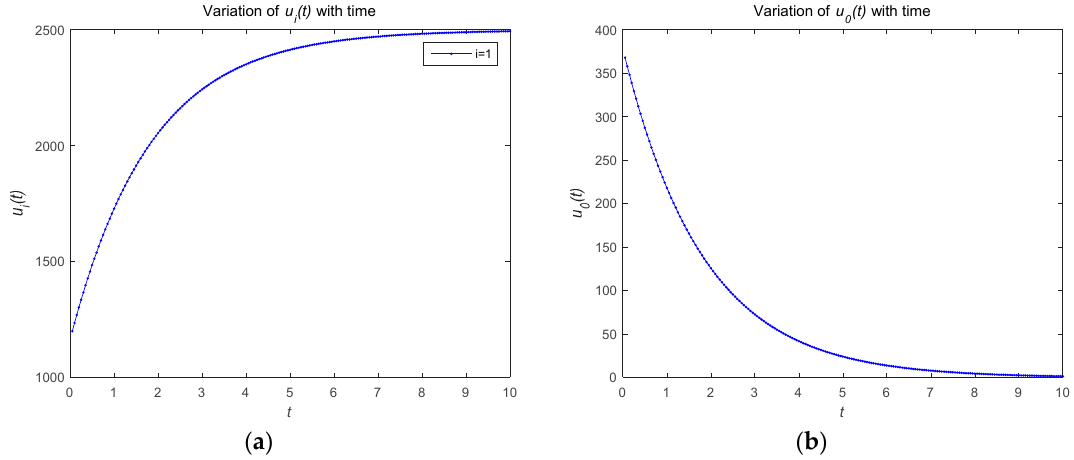
Figure 5. ( a ) Optimal strategy of the attacker; ( b ) optimal strategy of the defender.